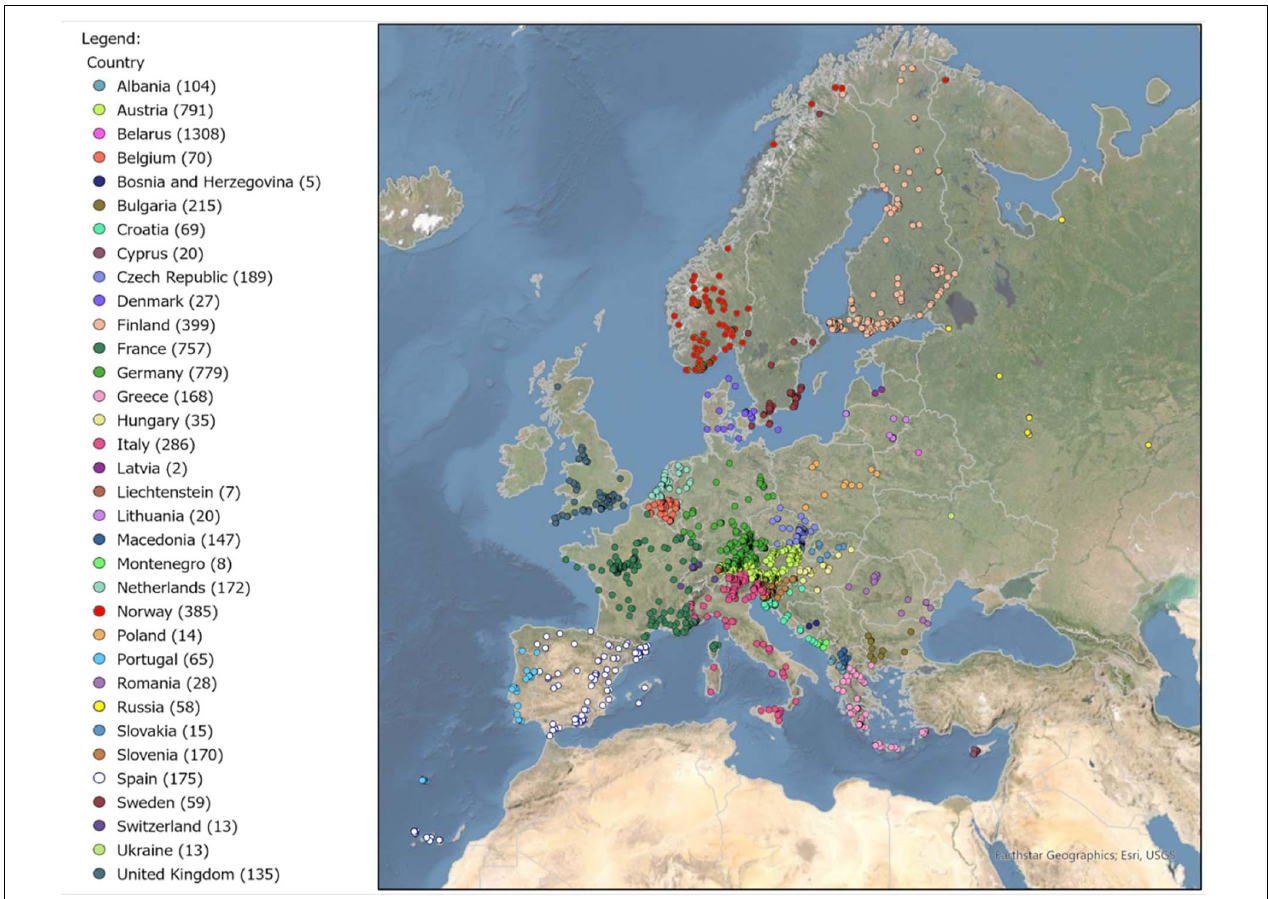
FIGURE 1 | Distribution of all georeferenced DNA barcode records used in this study across Europe. Number of DNA barcoded specimens per country is indicated in round brackets in the legend.